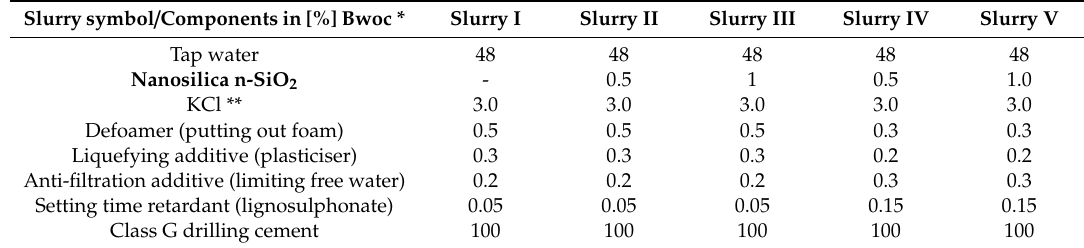
Table 4. Compositions of tested cement slurries with an addition of n-SiO 2